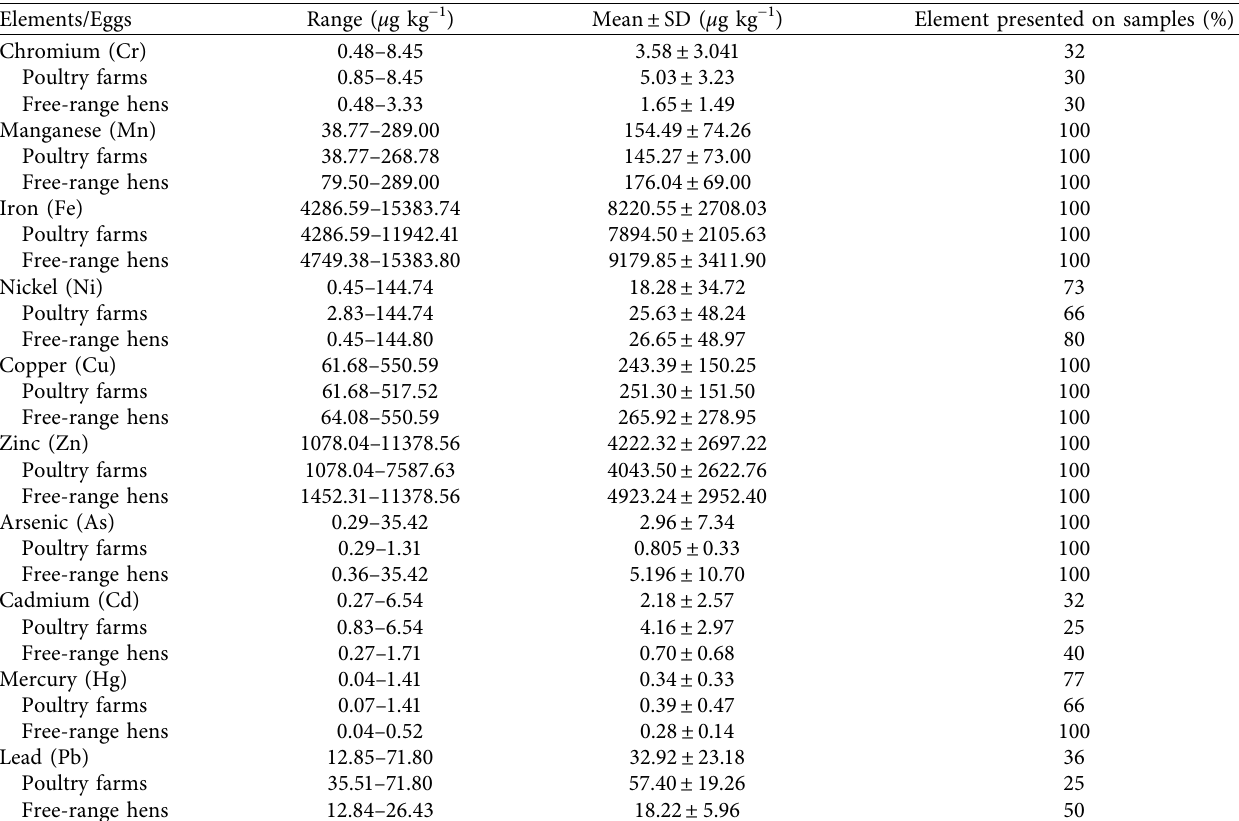
Table 1: Average concentrations and standard deviation of metals in hen eggs from poultry farms and free-range hens in parts per billion ( μ g kg − 1